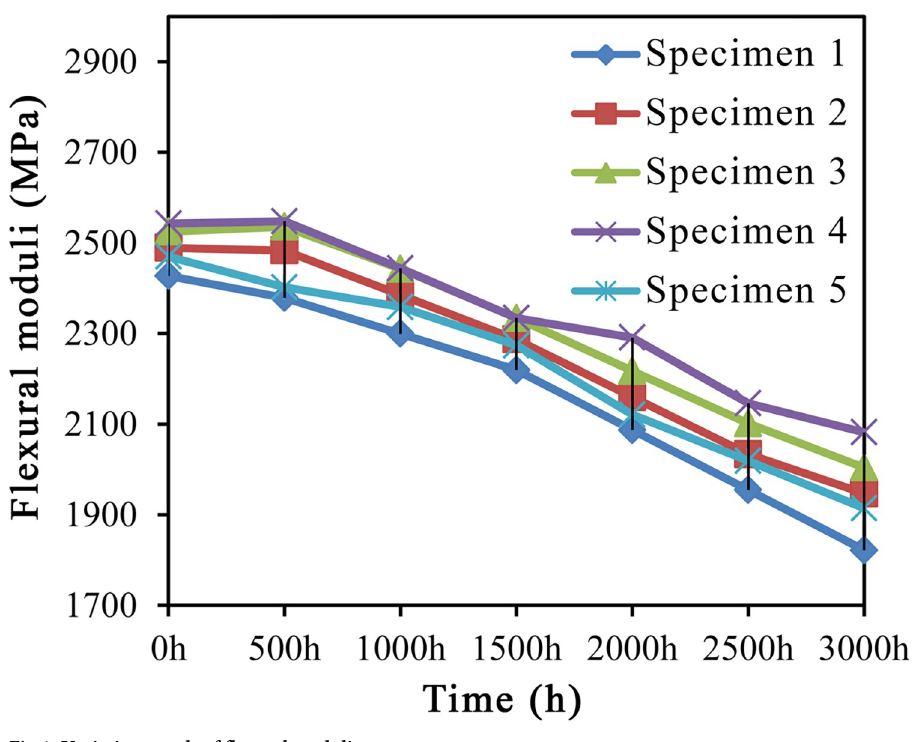
Fig 4. Variation trends of flexural moduli.